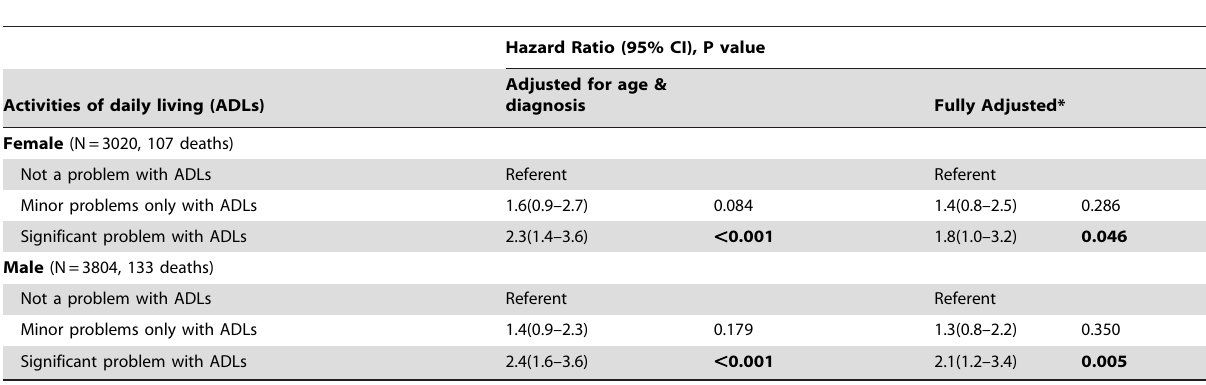
Table 3. Association between activities of daily living (ADLs) and all-cause mortality in individuals with serious mental illness stratified by gender.